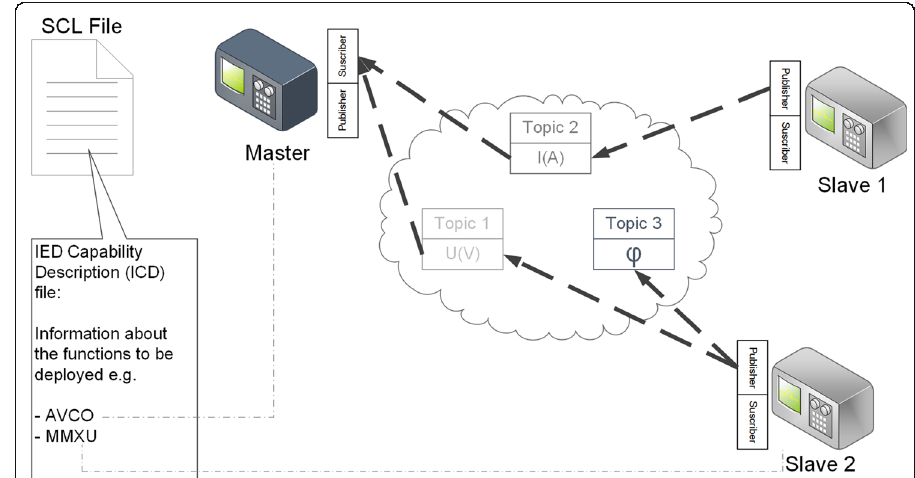
Fig. 4 Flexible data sharing